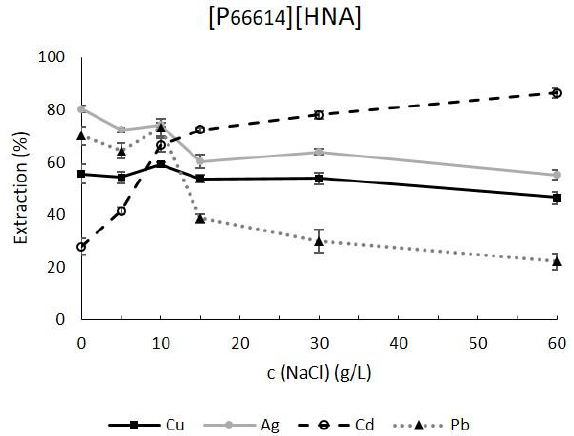
Figure 3. Effect of NaCl on extraction efficacy of solvent bars containing pure [P 66614 ][HNA] at pH 8.0 for an extraction time of 2 h (n = 3, error bars = ± SD).